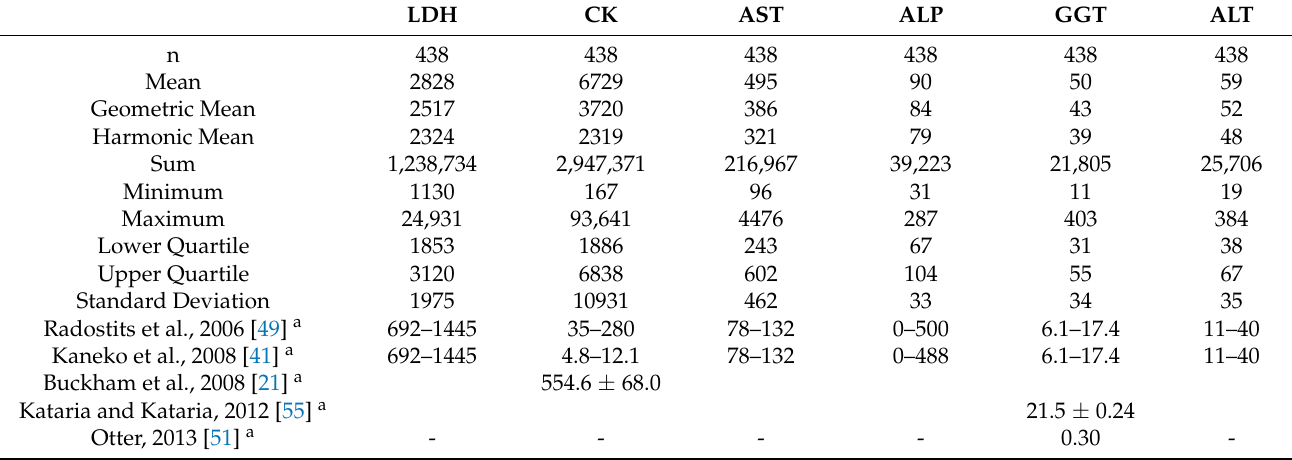
Figure 2. Graphic representation of the CK activity (UI/L) of bulls after physical exercise.